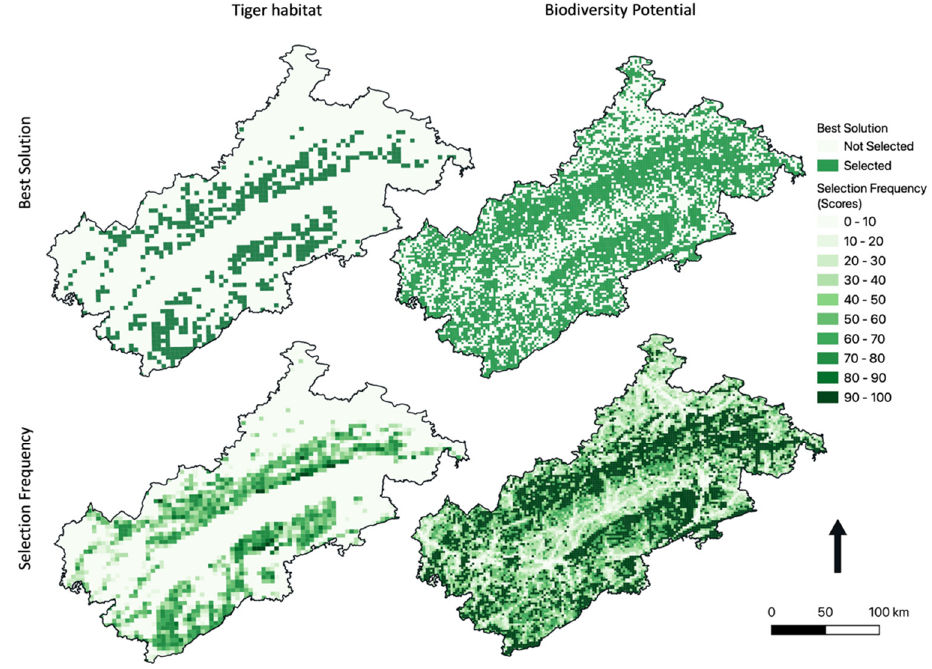
Figure 3. Marxan solution as best solution and selection frequency scores for tiger habitat and biodiversity